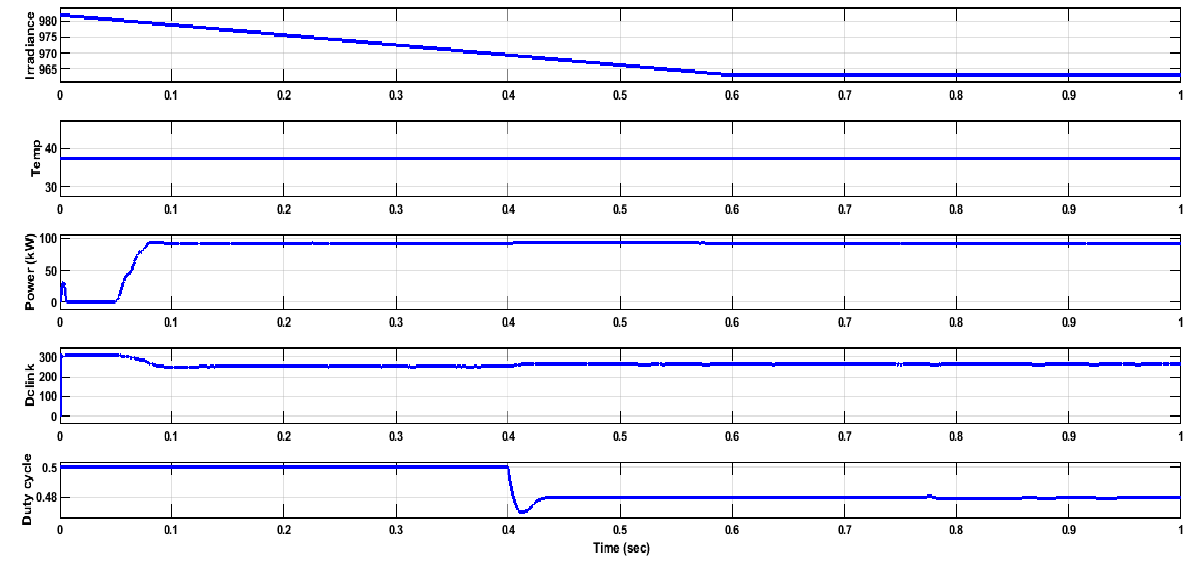
Figure 9. Performance analysis using the AOA method.